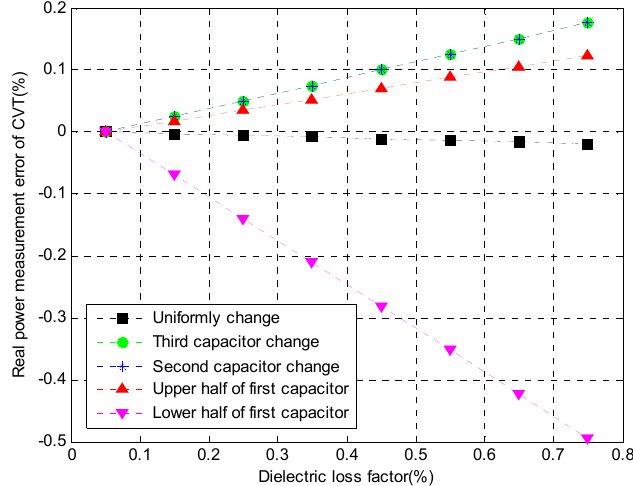
Figure 13. CVT real power measurement error with different dielectric loss factor.